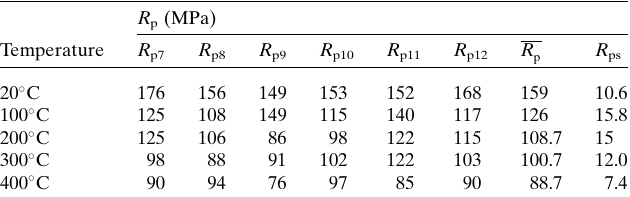
Table 8 Yield strength of EBW joints.